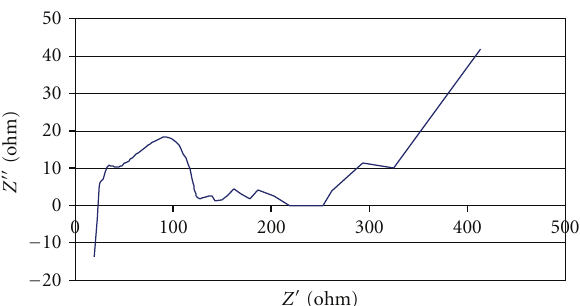
Figure 11: Nyquist plot from impedance testing of EDLC CFW- CNT-GF/F capacitor between 1 MHz and 0.03Hz; each carbon electrode has an area of 1 cm 2 and mass of 20.2mg.